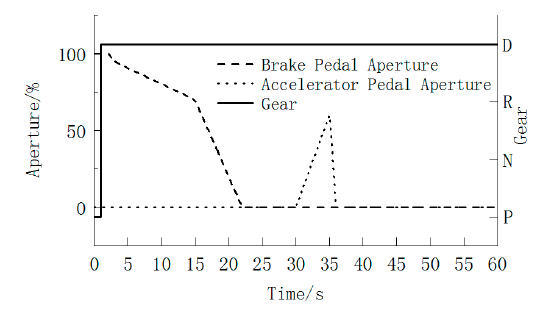
Figure 12. Control Process of Flat Road Conditions: ( a ) Driver Intention; ( b ) Mode Switching Diagram; ( c ) Curve of Motor Output Torque; ( d ) Curve of Vehicle Velocity; ( e ) Curve of Jerk.